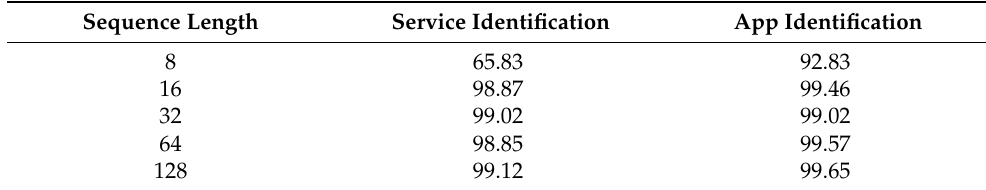
Table 4. Effect of sequence length (accuracy).